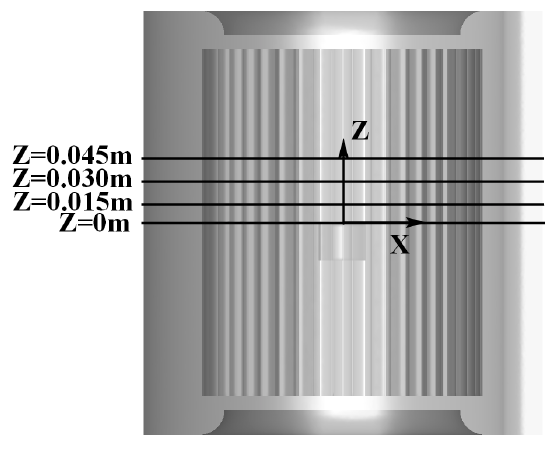
Figure 7. Di ff erent section positions of the centrifugal Figure 7. Different section positions of the centrifugal fan. Figure 7. Different section positions of the centrifugal fan.